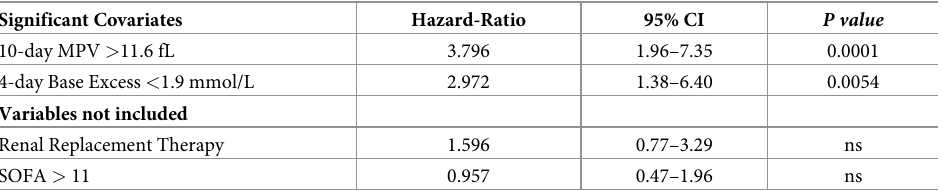
Table 3. Multivariate analysis (Cox Model).